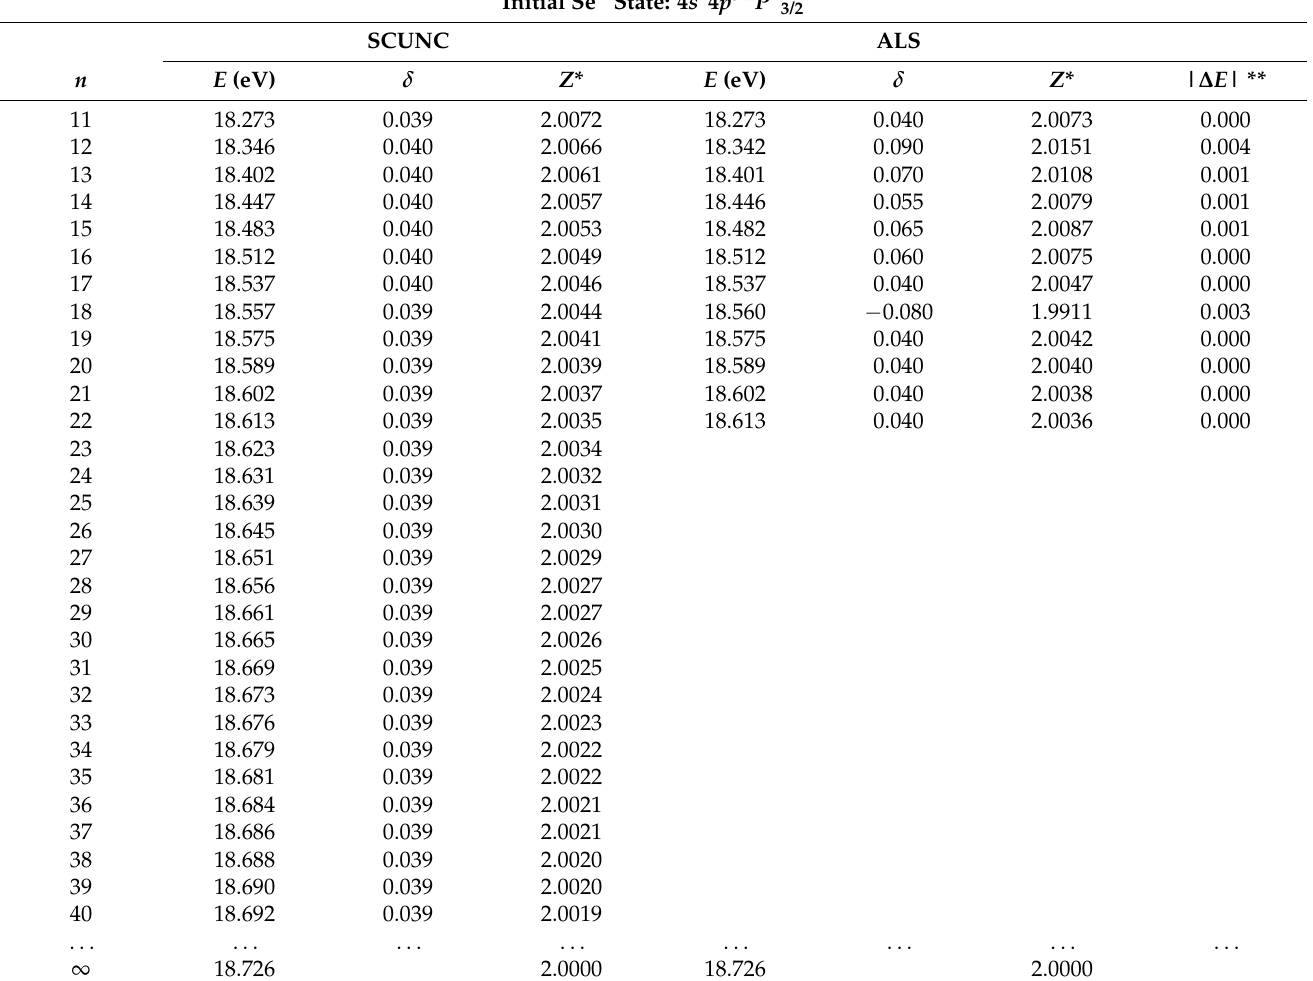
Table 2. Energy resonances ( E ), quantum defect ( δ ) and effective charge ( Z *) of the 4 s 2 4 p 2 ( 3 P 2 ) nd Rydberg series originating from the 4 s 2 4 p 3 2 P ◦ 3/2 metastable state of Se + converging to the 3 P 2 series limits in Se 2+ . The present results (SCUNC) are compared with the experimental data from ALS measurements [6]. The uncertainties in the experimental energies are stated to be ± 0.010 eV, f 1 ( 3 P 2 ; 2 P ◦ − 0.072 ± 0.042 with ν = 3/2 ) =